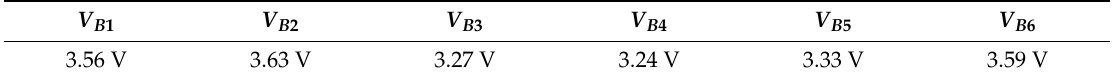
Table 4. Cells’ voltage of the unbalanced 6S1P battery module for the testing condition.